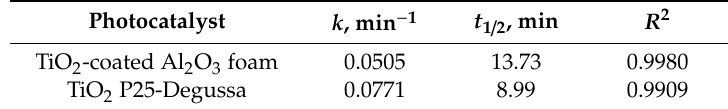
Table 2. The first-order degradation rate constant ( k ) and half-life (t 1 / 2 ) for memantine photodegradation by TiO 2 -coated Al 2 O 3 foam and suspended TiO 2 nanoparticles